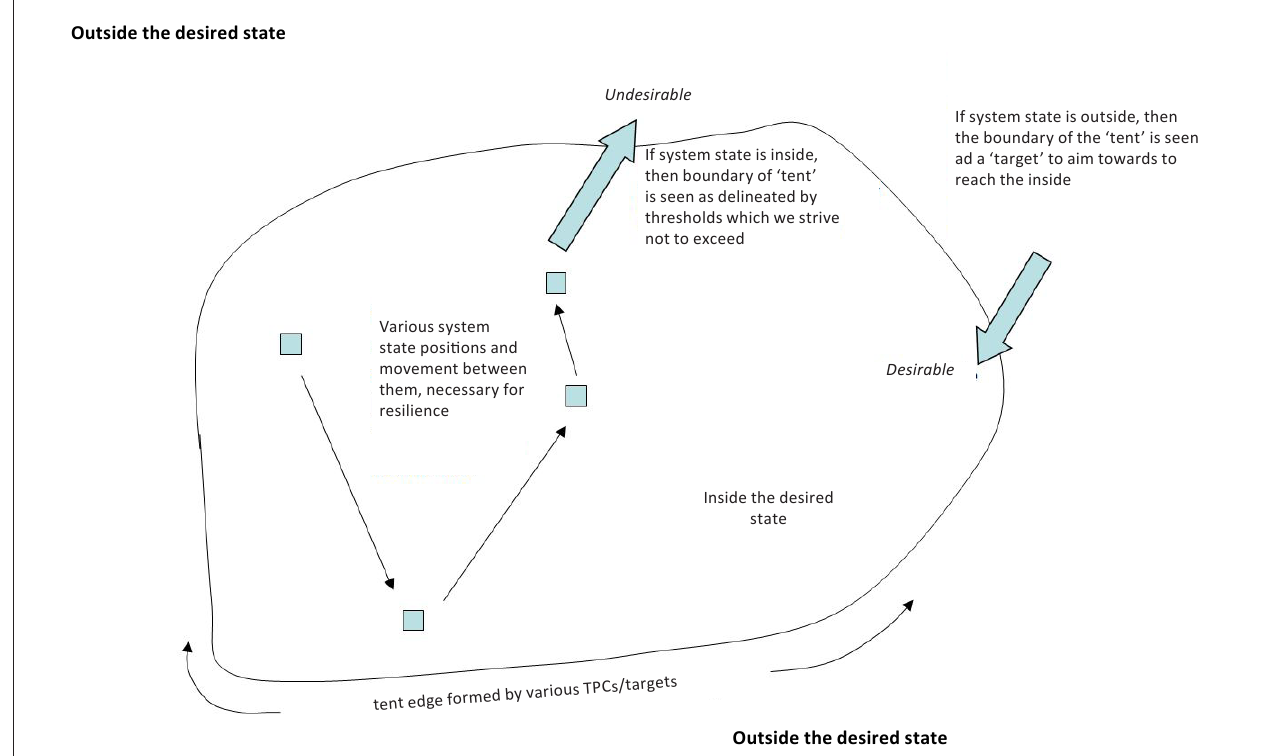
FIGURE 1: Two-dimensional schematic of the ‘tent of acceptability’ or ‘desired state envelope’.